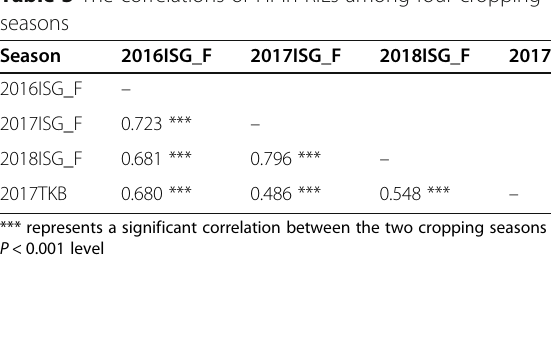
Table 3 The correlations of HI in RILs among four